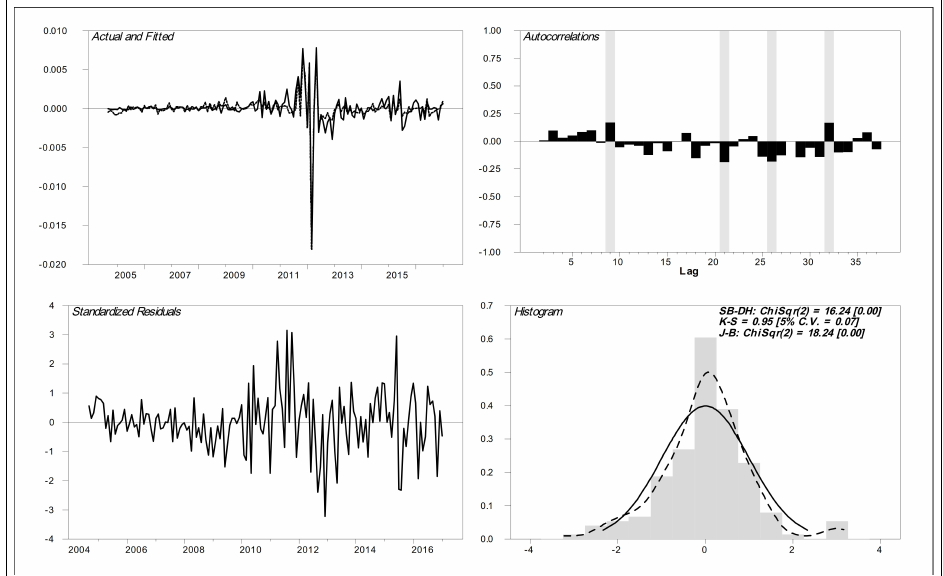
Figure 4: Graphs of actual and fitted change in the Greek bond rate (upper left hand side panel), the standardized residuals (lower left hand side panel), the residual autocorrelogram (upper right hand side panel), and the residual histogram compared to the normal distribution.